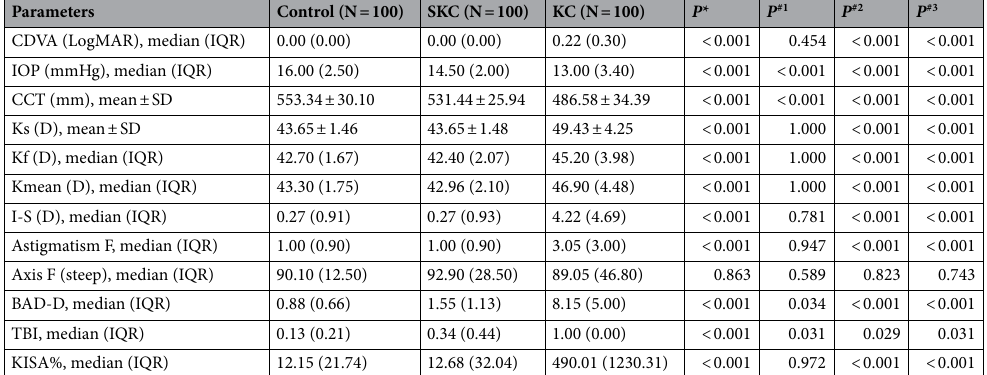
Table 1. Comparisons of basic parameters among control, SKC and KC eyes. SKC Subclinical keratoconus, KC Keratoconus, CDVA Corrected distance visual acuity, IOP Intraocular pressure, CCT Central corneal thickness, Ks Steep keratometric, Kf Flat keratometric, Kmean Mean keratometric, I–S Inferior-superior difference value, BAD-D Belin Ambrosio enhanced ectasia total deviation index, TBI tomographic and biomechanical parameters. *ANOVA or Kruskal–Wallis test, #1 control versus SKC; #2 control versus KC; #3 SKC versus